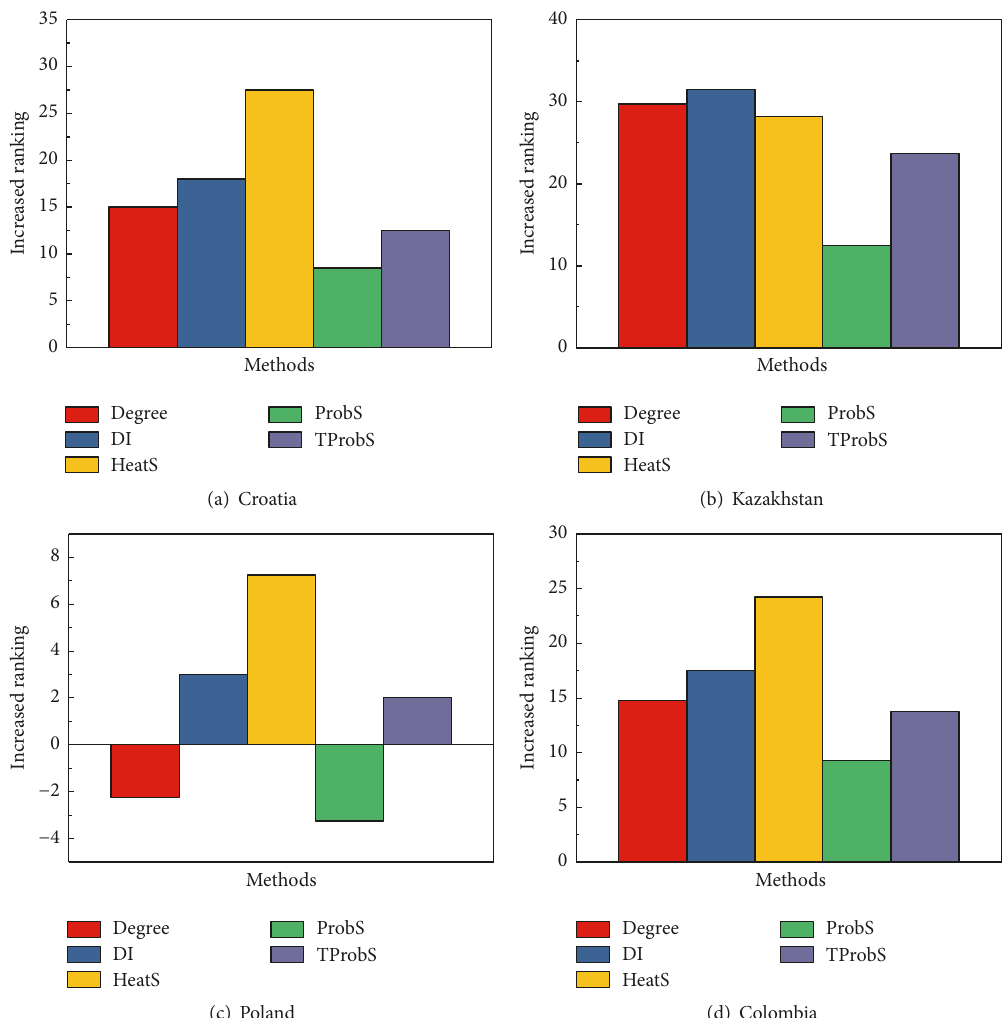
Figure 5: Comparison of the increased rankings of the four selected countries. The increased ranking of each method is averaged over different lengths of the recommendation list 𝐿 .